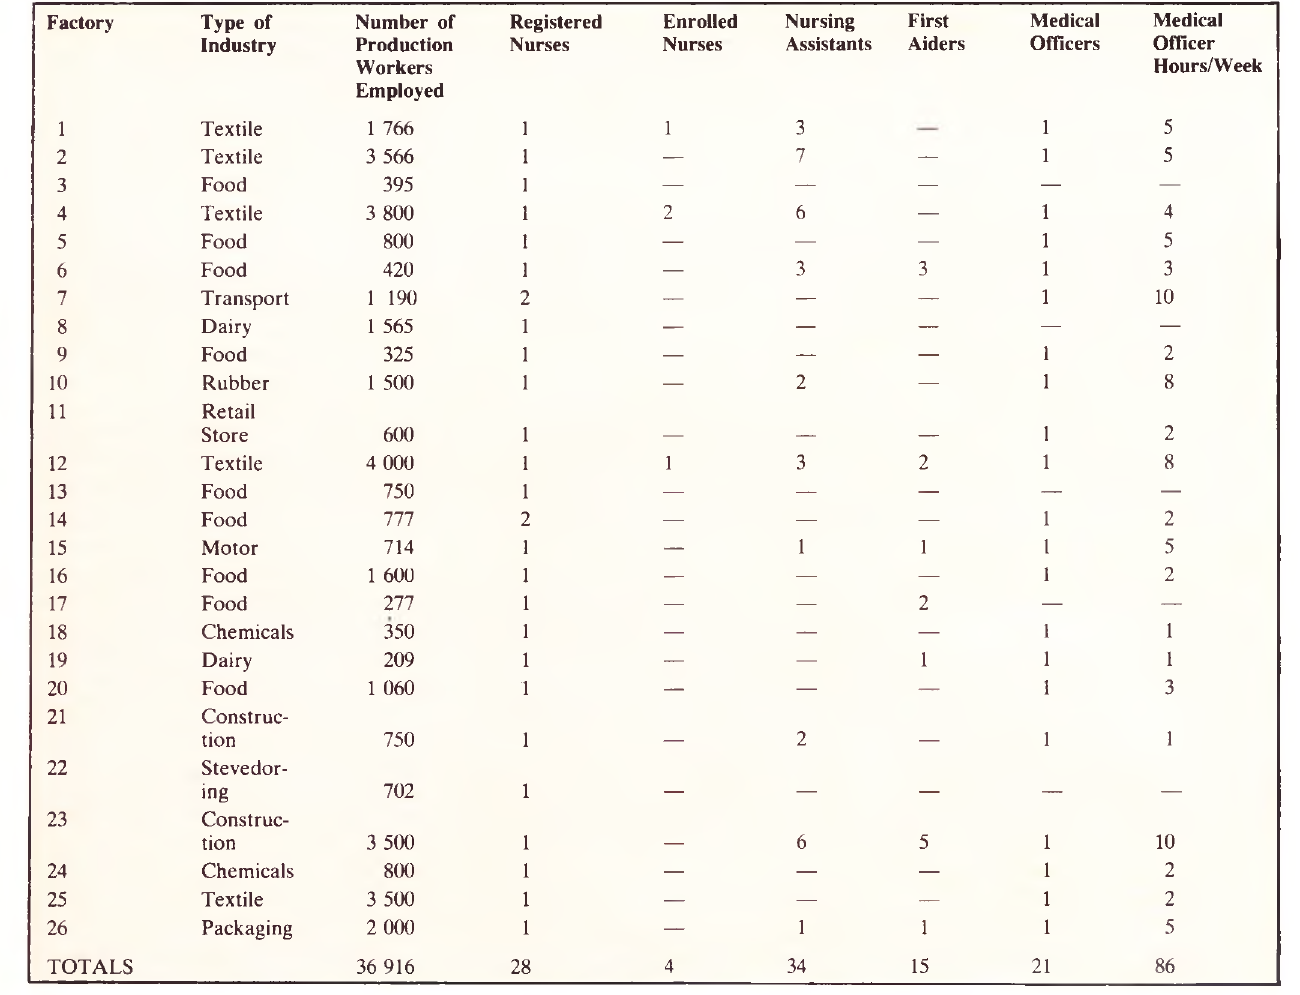
Table 1 Full-time Occupational Workers in 26 factories in